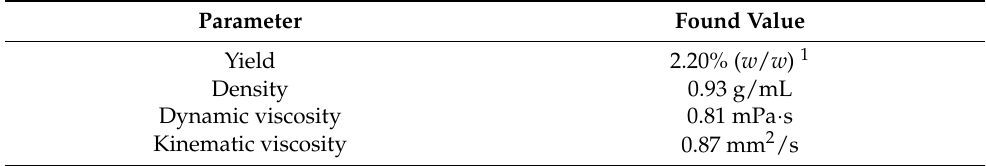
Figure 1. Extraction of essential oil from aerial part of Pipper auritum through hydrodistillation using a Clevenger apparatus. Table 1. Extraction of aerial part essential oil of P. auritum .